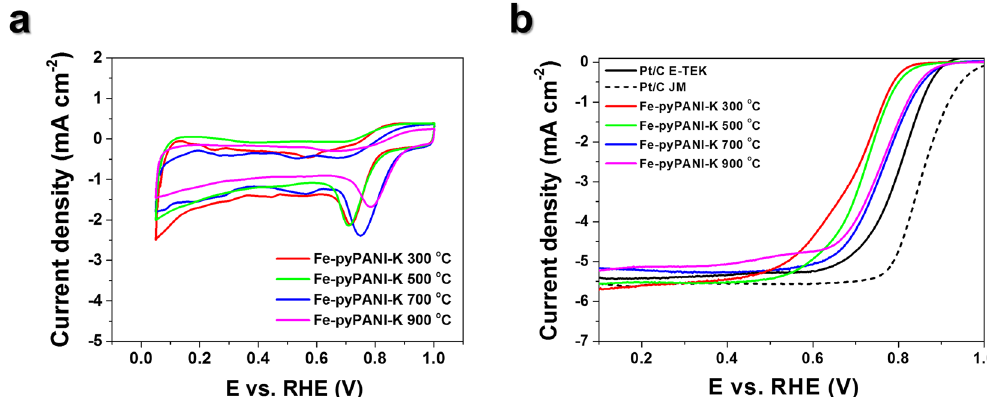
Figure 2. Electrochemical characterization for Fe-PANI-Ks pyrolyzed at difference temperature. ( a ) CV curves ( b ) ORR performance curves on RDE at 1600 rpm. Both CV and LSV data were obtained in O 2 saturated 0.1 M KOH solutions at 25 °C and catalyst loading for Pt/C and Fe-pyPANI-Ks was 0.24 mg cm − 2